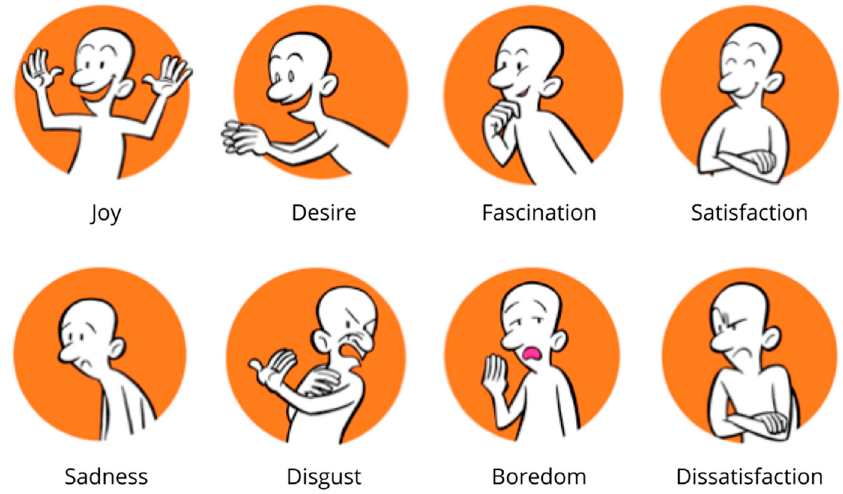
Figure 7. The LEMtool cartoon character and the expressed eight emotions. Adapted from [36].